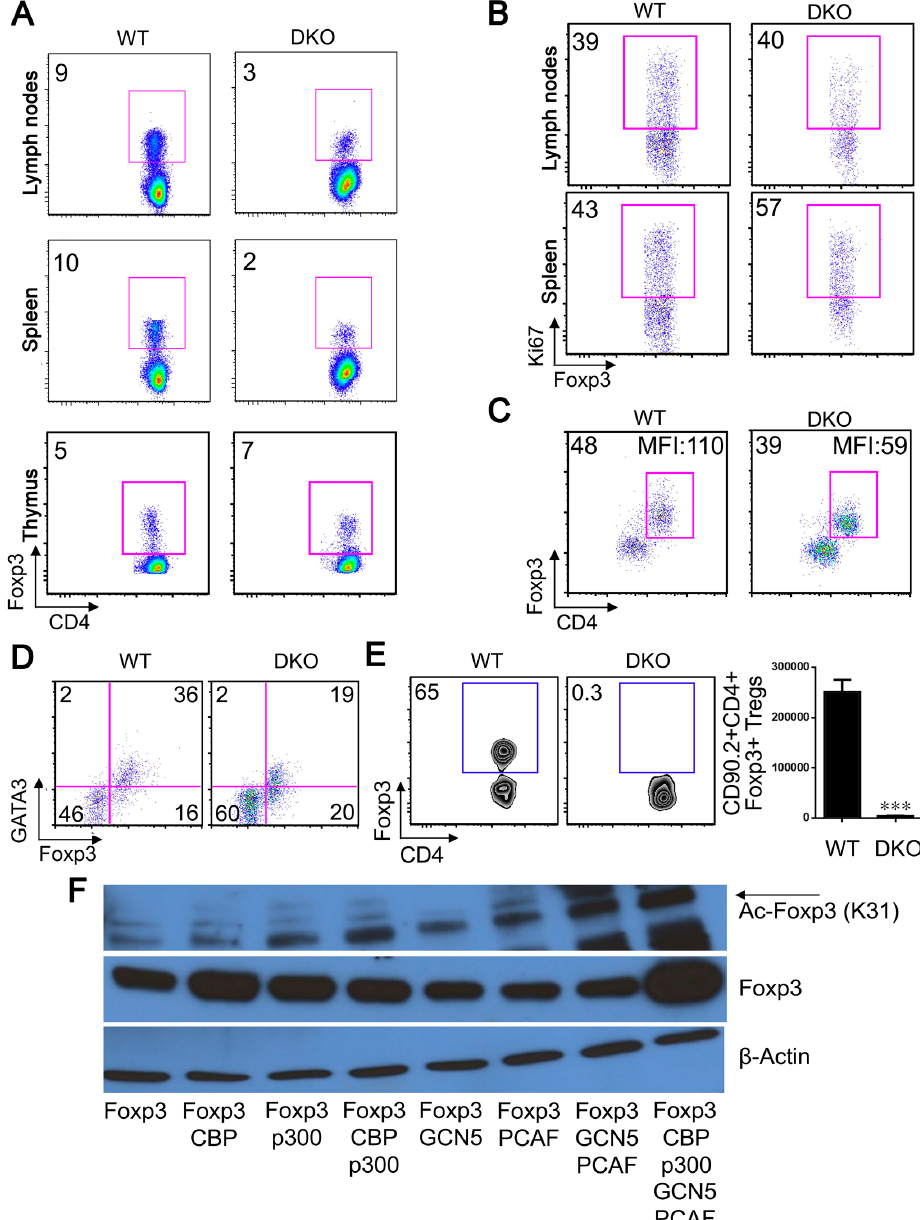
Figure 6. GCN5 and PCAF are critical for Treg stability. ( A ) Percentages of CD4 + Foxp3 + level in lymph nodes, spleens, and thymii of DKO and littermate control mice at 3 weeks of age. ( B ) Percentages of Foxp3+Ki67+ cells in WT and DKO mice; cells were gated on CD4+Foxp3+ cells. In panels ( C , D ), CD4+YFP + Tregs (1 × 10 5 ) were sorted from Foxp3 YFP or DKO mice, stimulated in vitro with plate-bound CD3/CD28 mAbs plus IL-2 for 3 days. ( C ) CD4+Foxp3+ percentage and mean fluorescent intensity (MFI) shown in each panel. ( D ) Percentages of GATA3+ in CD4+Foxp3+ cells are shown. ( E ) Percentage and absolute numbers of CD90.2+CD4+Foxp3+ cells at 4 weeks after i.v. adoptive transfer of CD4+YFP+ Treg cells (1 × 10 5 ), isolated by cell sorting from Foxp3 cre or DKO mice, into B6/Rag1 − / − host mice; each sorted Treg population was co-transferred with CD4+CD25 − CD90.1+ Teff cells (5 × 10 5 ) and *** p < 0.001. ( F ) 293T cells were transfected with Foxp3 alone or plus CBP, p300, GCN5, PCAF; after 48 h, cell lysates were subjected to Western blotting as indicated, and β -actin was used as a loading control. Data are representative of 3 independent experiments.